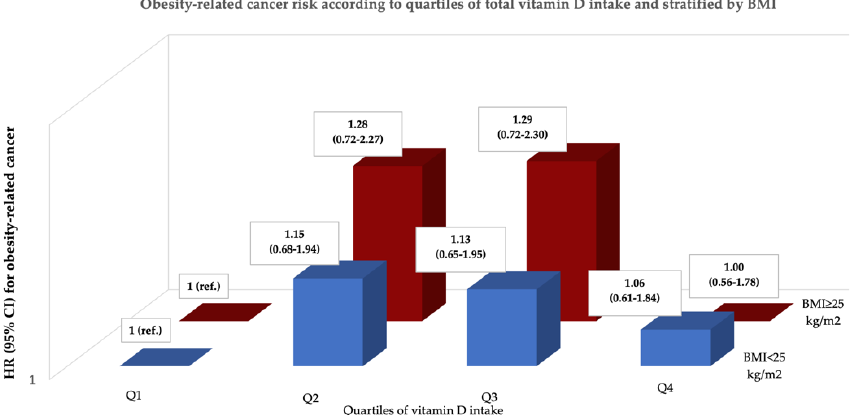
Figure 3. Hazard ratio (95% CI) of obesity-related cancer according to quartiles of total vitamin D intake and BMI strata (normal weight and overweight/obesity). Adjusted for sex, height (cm), family history of breast or colorectal cancer (yes/no), smoking habit (never, current, or former smoker), lifetime tobacco consumption (pack-years), years of university studies, physical activity (MET-h/week), alcohol consumption (g/day), total energy intake (kcal/day), consumption of sugar-sweetened beverages (servings/day), coffee consumption (servings/day), TV-watching (h/day), sunlight exposure (h/year), intensity of solar irradiation (kWh/m 2 /day), and adherence to Mediterranean Diet Score (0 – 8 points).